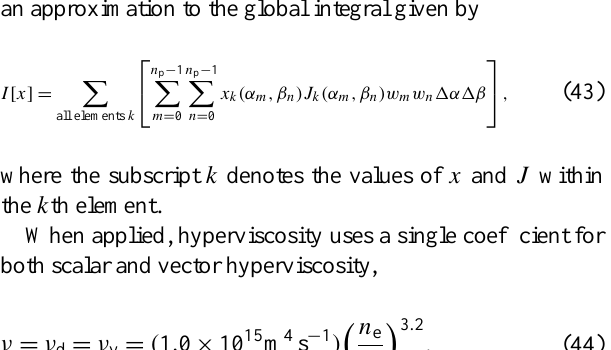
Figure 4. L 2 error time series for geostrophically balanced flow on the cubed sphere for n e = 16 and n p = 4 over a 5-day integration period for all continuous and discontinuous Fig. 4. L error time series for geostrophically balanced flow on the cubed-sphere for n 2 over a 5 day integration period for all continuous and discontinuous schemes.